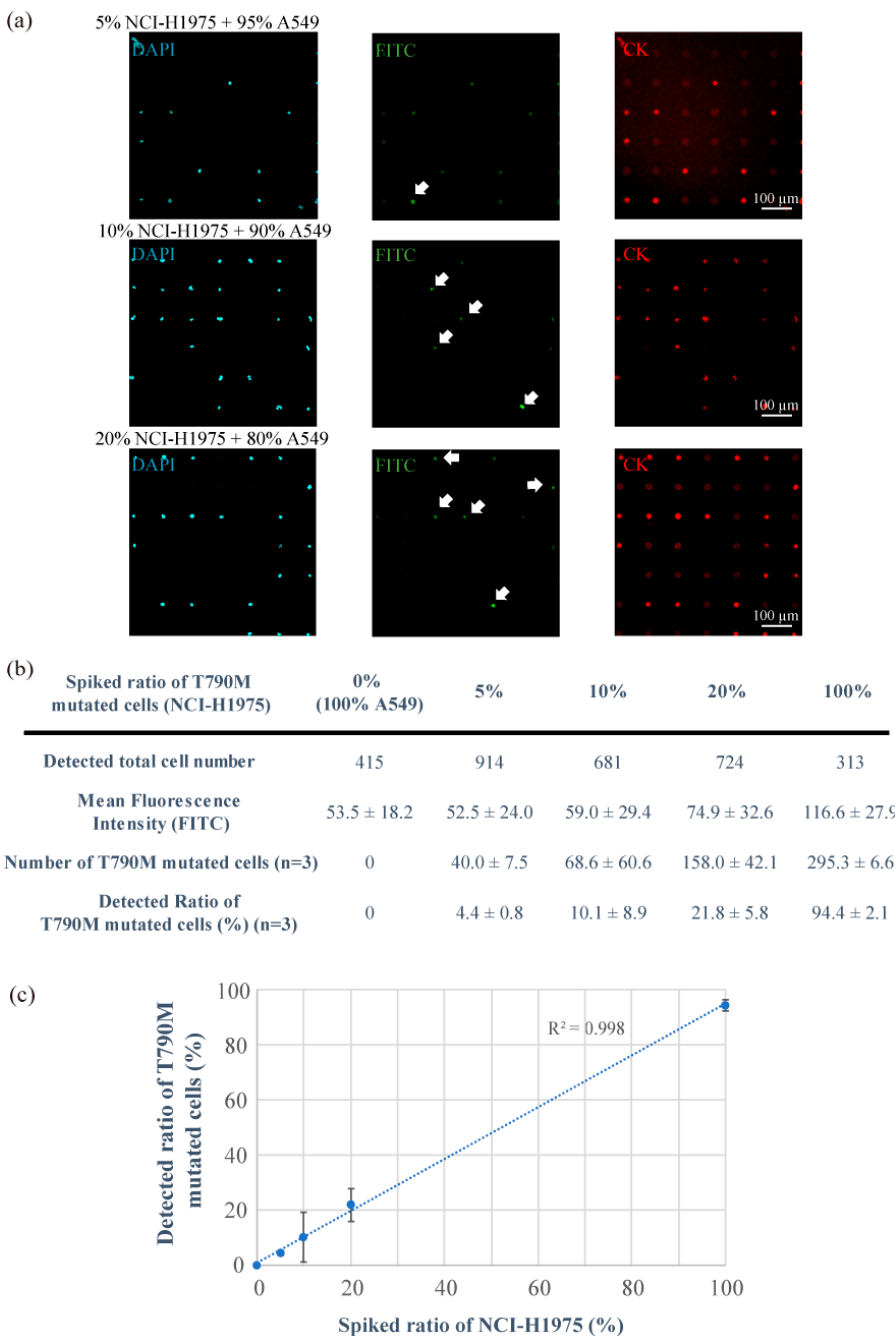
Figure 3. Analysis of the ratio of T790M-mutated cancer cells (NCI-H1975) spiked into non-mutated cells (A549) using combination technology with the single-cell microarray chip and peptide nucleic acid (PNA)-DNA probe. ( a ) Representative fluorescent images of 5%, 10%, and 20% NCI-H1975 cells spiking into A549 cells stained with diluted 4,6-diamidino-2-phenylindole (DAPI; blue), fluorescein isothiocyanate (FITC)-conjugated PNA-DNA probes (green), and phycoerythrin (PE)-labeled cytokeratin (CK) antibody (red). White arrows indicate positive cells (T790M-mutated). ( b ) Information on the number and ratio of T790M-mutated cells (NCI-H1975) spiked into A549 cells. ( c ) Linearity plots for the spiked and detected ratio of T790M-mutated cells (NCI-H1975) spiked into A549 cells. R 2 indicates the correlation coefficient. The results are shown as the mean ± standard error of the three replicates.